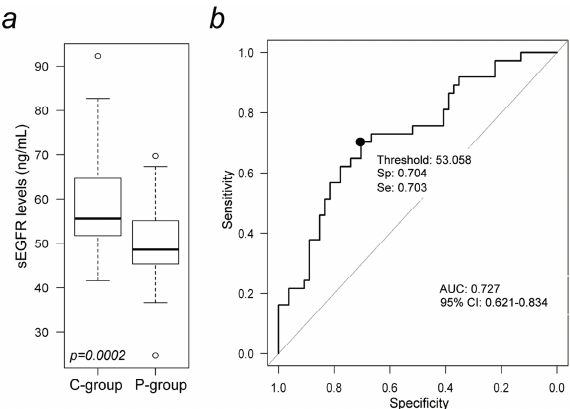
Figure 1. Quantification and diagnostic accuracy analysis of sEGFR levels in plasma of NSCLC patients and healthy controls. ( a ) Box plot illustrate the distributions of sEGFR (ng/mL) levels in plasma from 37 NSCLC patients (P-group) and 54 healthy controls (C-group). Horizontal bold line, median value; the interquartile range is indicated above and below each bar; circles, outliers; ( b ) The receiver operating characteristic (ROC) curves of plasma sEGFR in discriminating NSCLC patients from healthy subjects. The area under the ROC curves (AUC) was 0.727 (95% CI: 0.621 to 0.834). The point on the curve indicates the cut-off value (53.058 ng/mL), for which sensitivity and specificity were 70.4% and 70.3%, respectively. The odds ratio according to the cut-off value was 5.613 (95% CI: 2.247 to 14.023). Table 2. sEGFR concentration according with demographic, clinical, and/or pathological characteristics.